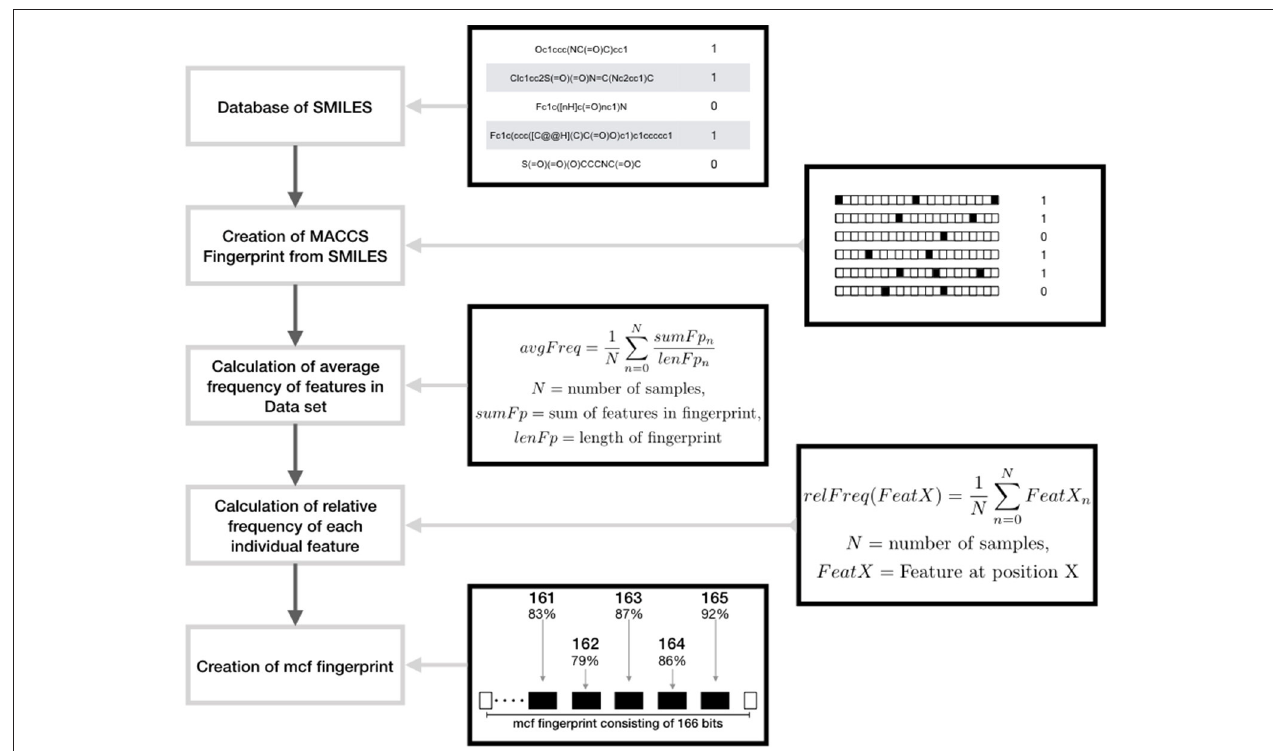
FIGURE 1 | Schematic representation showing the design of maximum common feature (MCF) fingerprints using features derived from MACCS